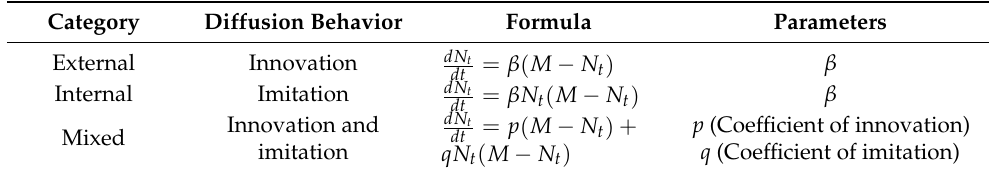
Table 2. Category of Diffusion model. [36].